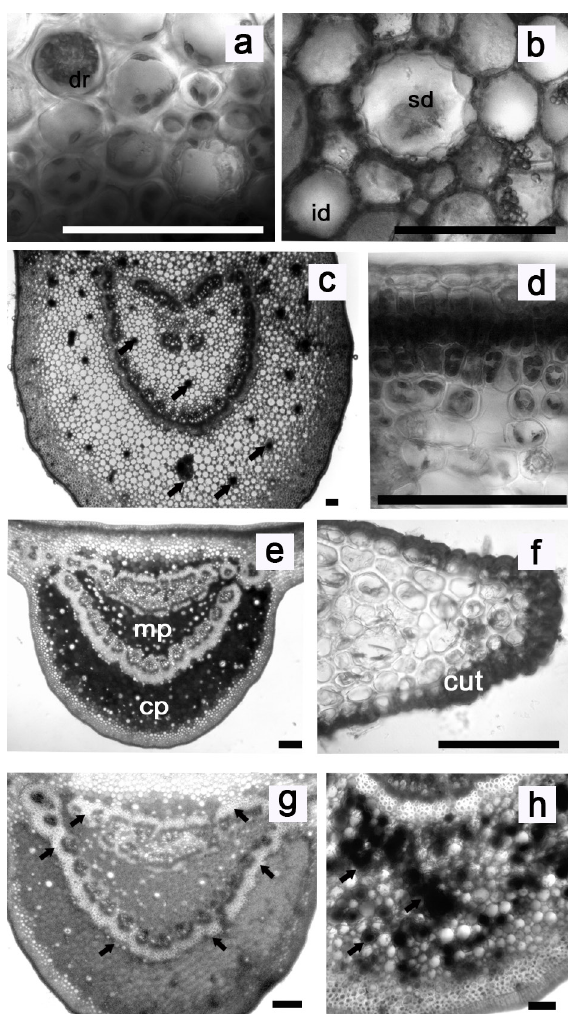
Figure 2 - Anatomy and histochemistry of C. criuva . a : Secretory duct and druse in the collenchyma ring of the midrib; b : Secretory cavity in the cortical parenchyma of the petiole; c : Overview of the petiole stained with the Dragendorff reagent; d : Starch grains in chlorophyllian parenchyma of the intercostal space; e : Overview of the midrib stained with ferric chloride; f : Overview of the leaf edge stained with Sudan III; g : Overview of the midrib stained with phloroglucinol, showing sclerenchyma fibers around the vascular cylinder; h : Midrib stained with hydrochloric vanillin, structures containing tannins are indicated by arrows. mp: Medullary parenchyma; cp: Cortical parenchyma; cut: Cuticle; sd: Secretory ducts; id: Idioblasts; dr: Druse. Scale bar = 100 µm, except in Fig. 1D (Scale bar = 5